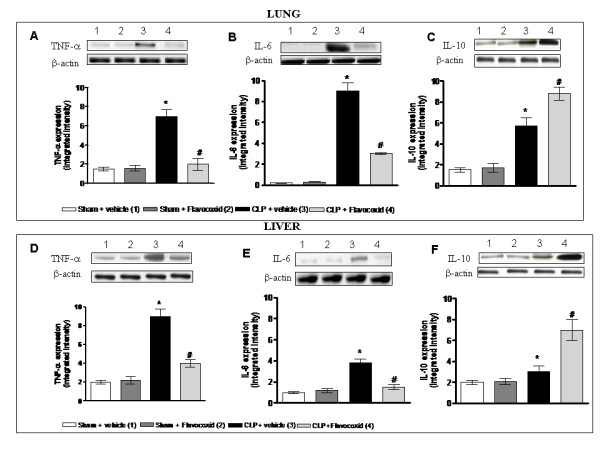
Western blot analysis of TNF-α, IL-6, and IL-10 in the lung (a through c) and liver (d through f) of CLP and sham mice. Animals were treated with flavocoxid (20 mg/kg, ip) or vehicle (NaCl 0.9%) 1 hour after surgery, repeated every 12 hours. Bars represent the mean ± SD of six animals. *P < 0.005 compared with sham + vehicle or flavocoxid; #P < 0.005 compared with CLP + vehicle.